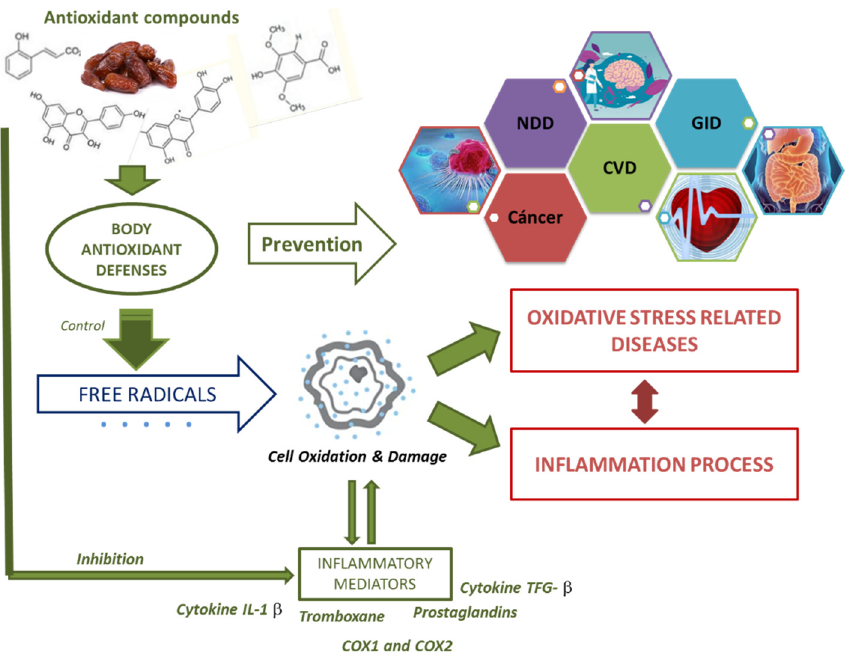
Figure 4. Anti-inflammatory activity of date compounds based on their antioxidant properties. NDD: neurodegenerative diseases; CVD: cardiovascular diseases; GID: gastrointestinal diseases.